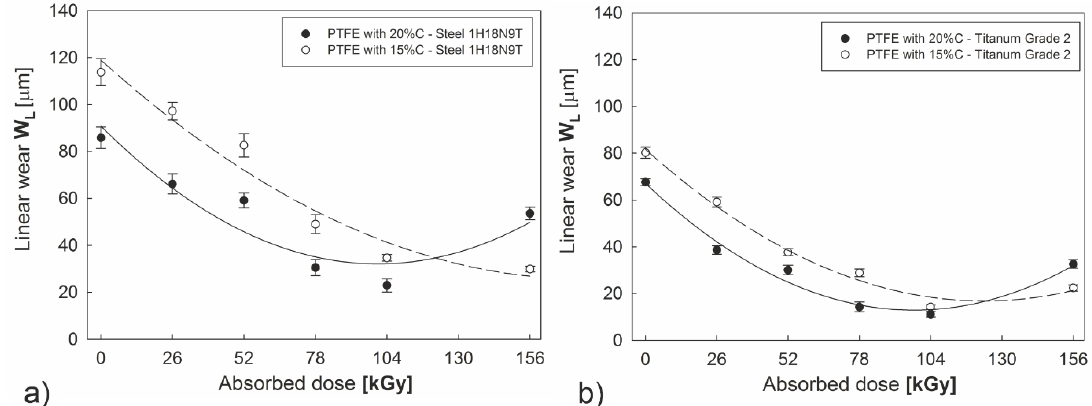
Figure 10. Linear wear of PTFE-graphite composites in combination with discs made of steel ( a ) and titanium grade 2 ( b ) as a function of electron beam irradiation.